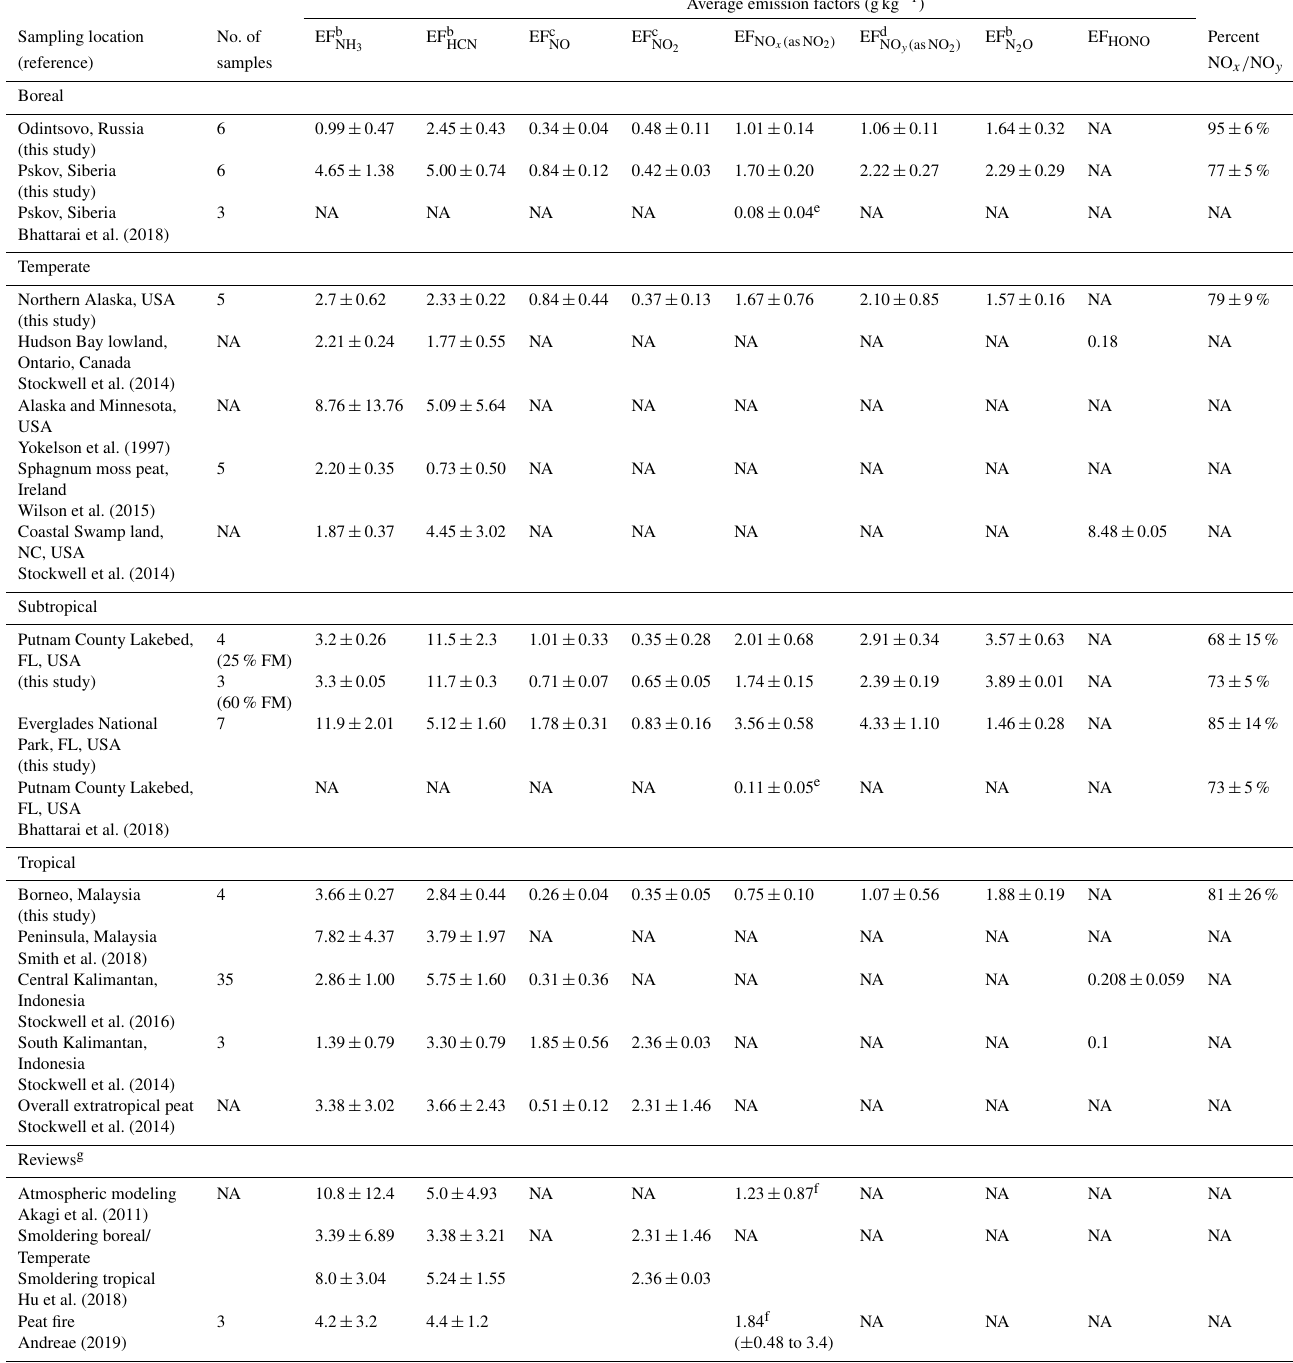
Table 3. Peat combustion emission factors (EFs) for gaseous nitrogen species a